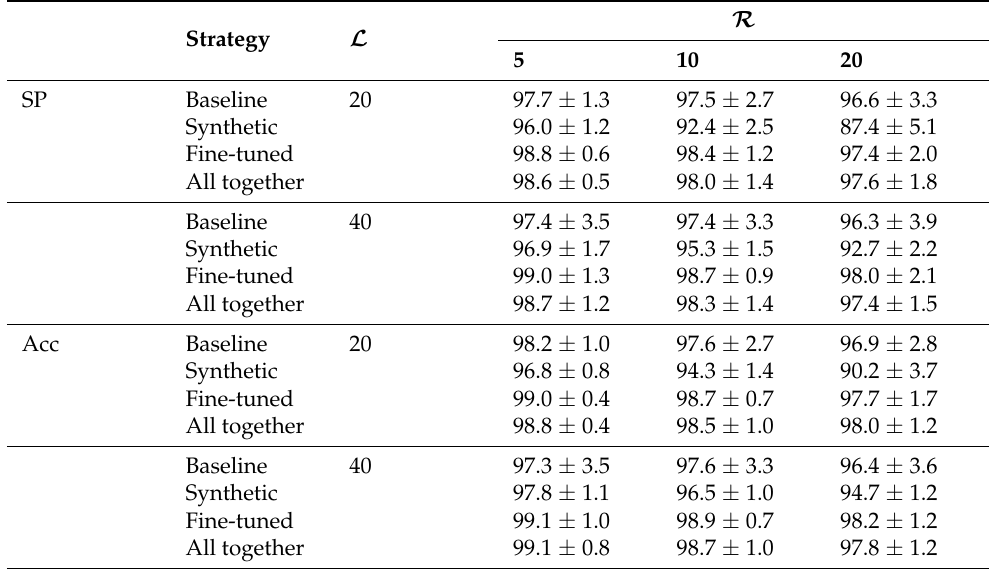
Table 5. Maximum SP index and accuracy computed for several values of the L and R parameters applied to the different strategies